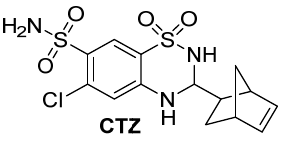
Table 1. The changes in the kainate-induced Purkinje cell currents upon treatment with com- pounds 1a – p .